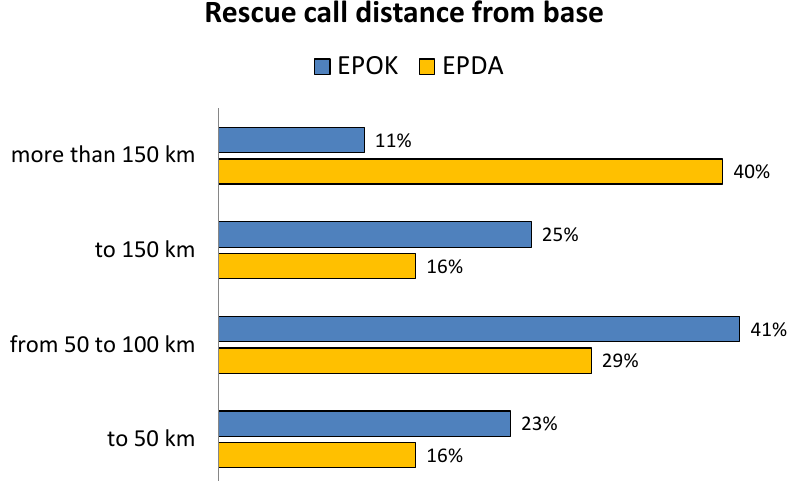
Figure 9. Distance distribution for missions that started from EPOK and EPDA bases in 1995–2001; W3-RM and Mi-13PS helicopters were used.